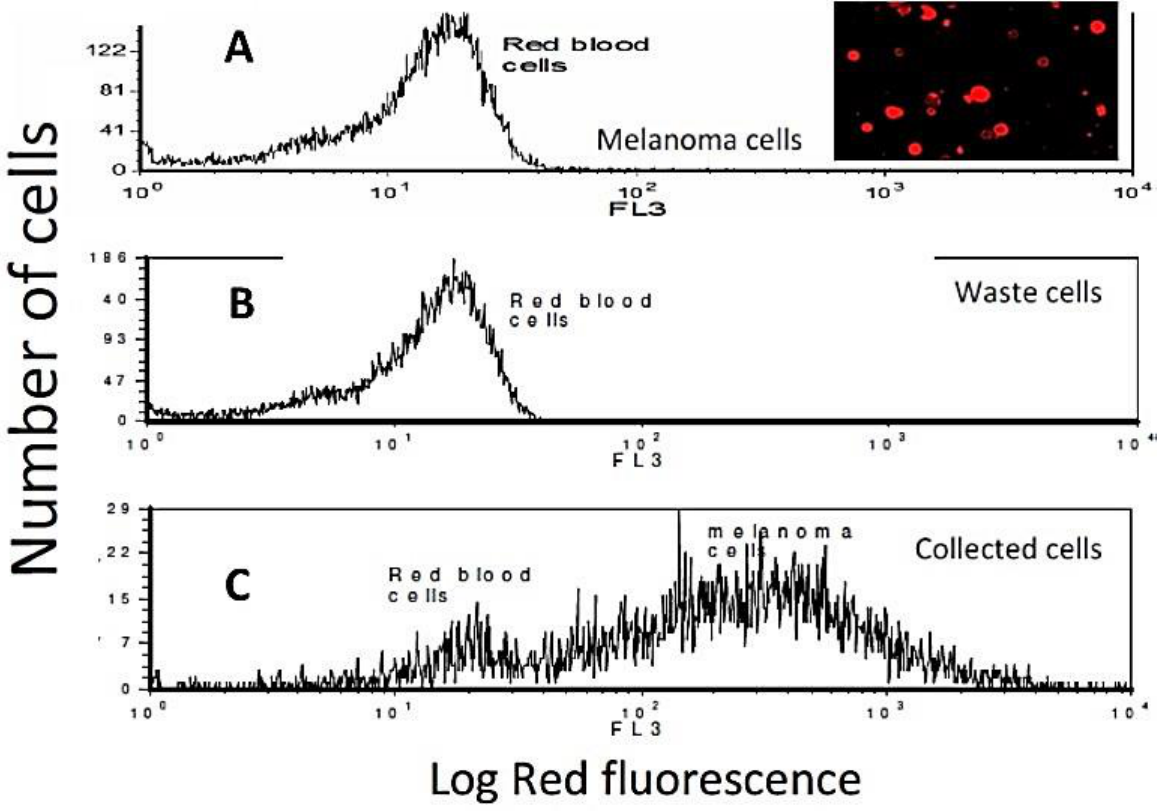
Figure 9. Flow cytometric analysis of magnetic Qdot-labeled human melanoma cells spiked into human whole blood at a ratio of 1:10,000. ( A ): Fluorescence histograms of the cell mixture before magnetic separation and color fluorescence micrograph demonstrate an example of the red fluorescent anti-CD146 Qdot labeled CRL11147 cell populations. ( B ): The RBCs collected in the waste. No melanoma cells could be counted. ( C ): Cells collected from the trap after removal of the magnetic field. Cells below FL3 = 50 are not fluorescent, and are mainly